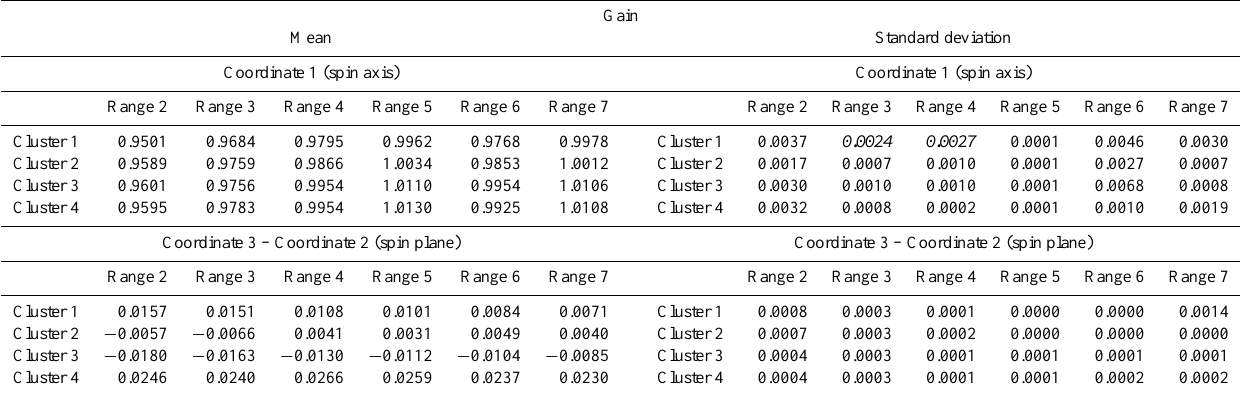
Table 3. Mean and standard deviation of gains ( G 1 and 1G 32 ) for the mission segment from February 2001 to February 2012 for each coordinate in every range on all spacecraft. Standard deviations for ranges that are at least twice as large as those for all the other spacecraft in that range are highlighted in